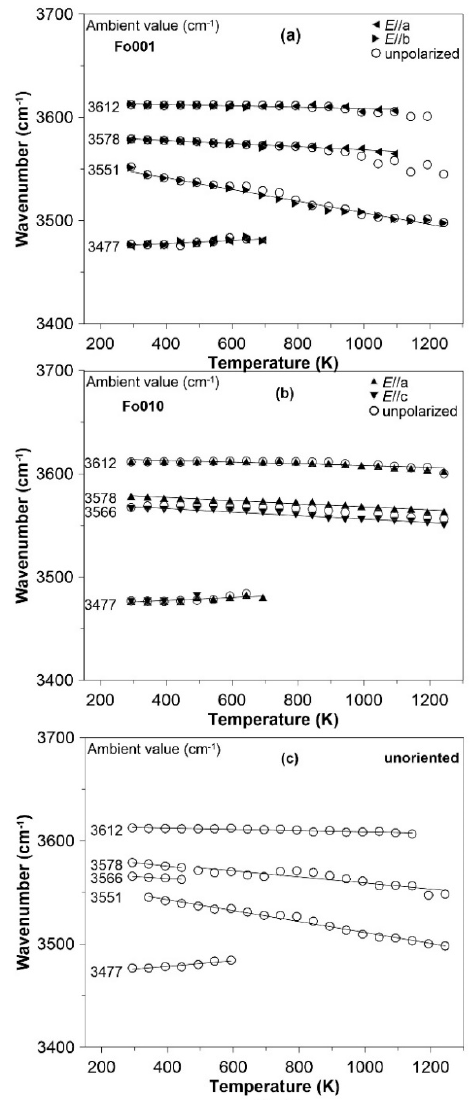
Figure 7. Variation of the frequencies for the OH bands with temperature for the oriented Fo001 ( a ) and Fo010 ( b ) samples, as well as the Fo-unoriented ( c ). Linear regressions (solid lines) are fitted for the datasets and the frequencies of at room temperatures are also listed in the figures.